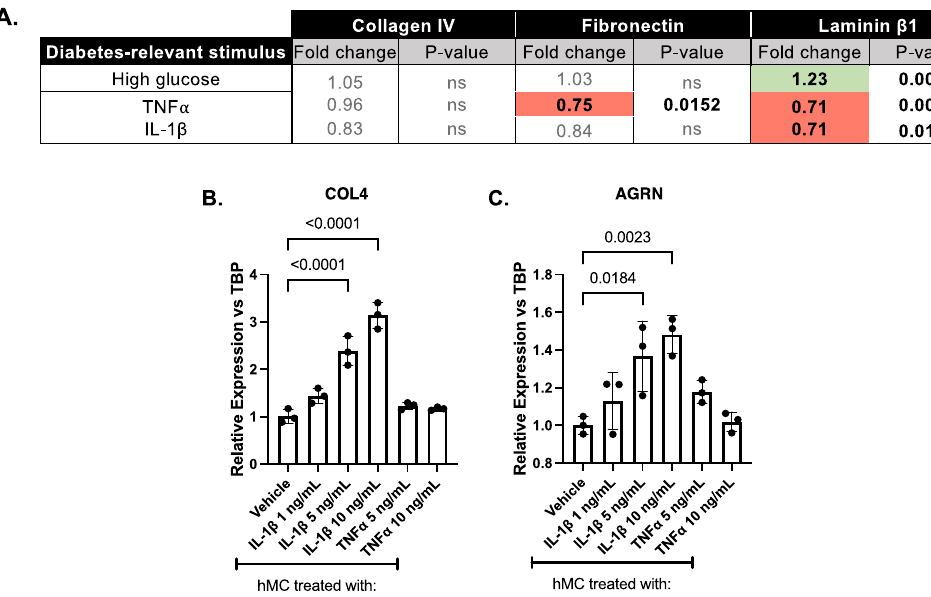
Figure 1. hMC-derived inflammation can influence hRMEC ECM expression. ( A ) All statistics are t-tests between the DRS-treated group and its respective vehicle. Expression data are reported as fold induction over vehicle. Red cells highlight statistically significant decreases in expression; green cells highlight statistically significant increases in expression. ( B , C ) Conditioned media (CM) was collected from IL-1β- or TNFα-treated hMC. hRMEC were treated with CM from hMC and then collected and assayed for expression of collagen IV or agrin. Expression data are reported as fold induction over vehicle with bars representing mean ± SD (n = 3 for all groups).